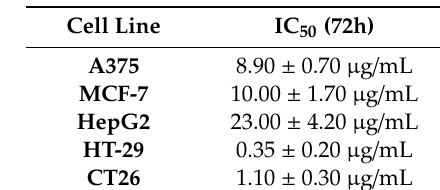
Table 2. IC 50 values (e ffi cient concentration that causes a 50% decrease in cell growth) of OOEO against di ff erent cancer cell lines determined with the SRB assay after a 72 h treatment. Data are representative of at least three independent experiments and are presented as mean ± SD.